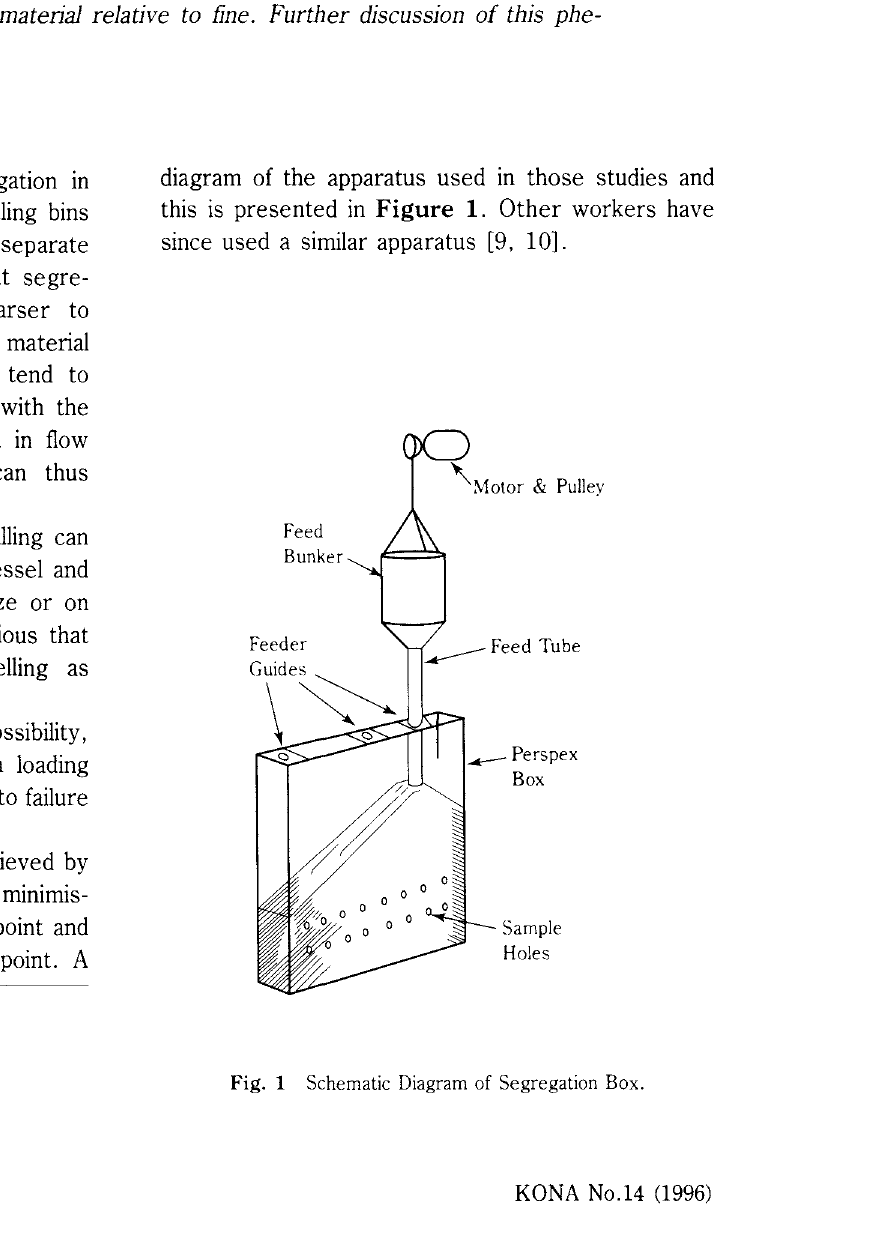
Fig. 1 Schematic Diagram of Segregation